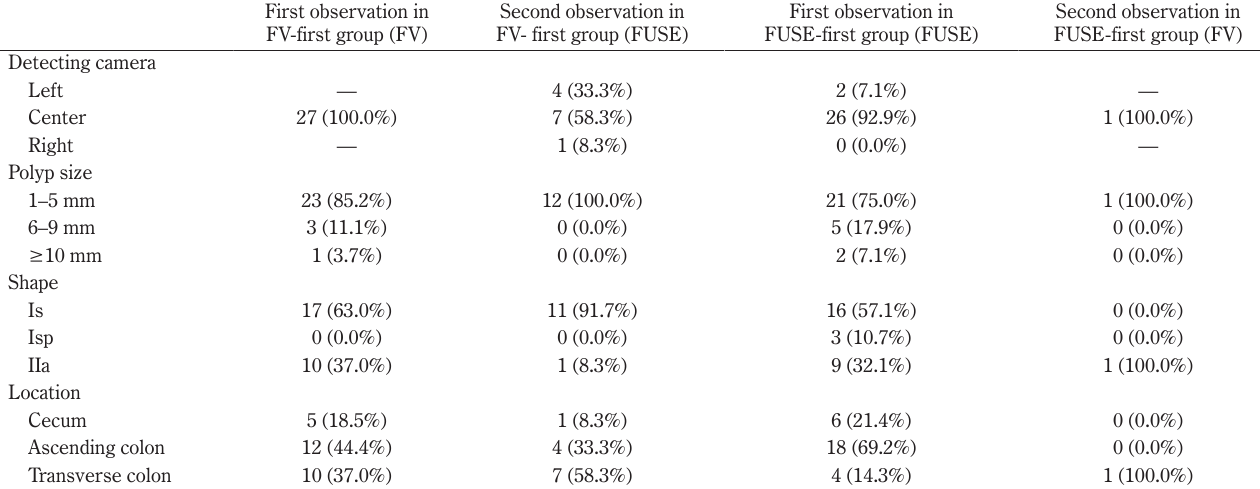
Table 3 Characteristics of polyps detected